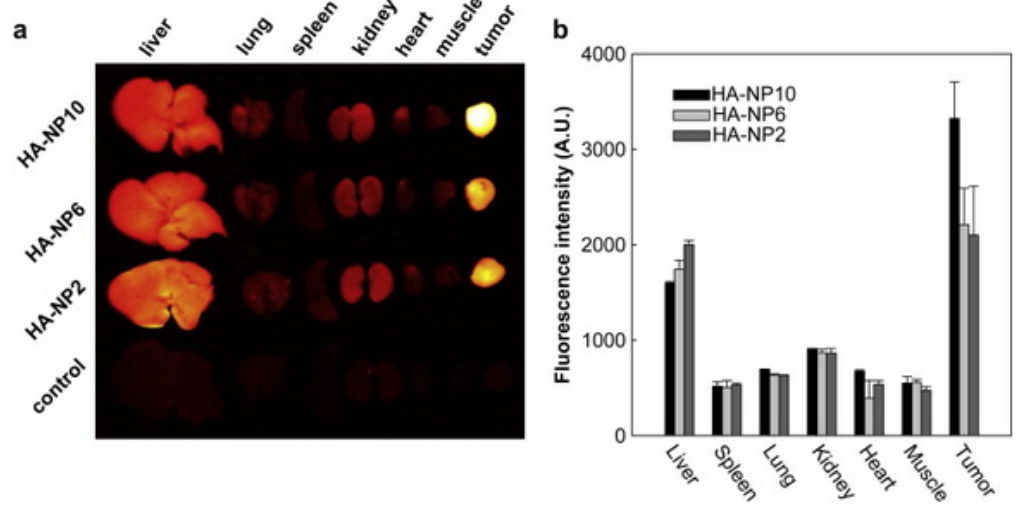
Figure 6. ( a ) Ex vivo fluorescence images of normal organs and tumors collected at two days post-injection of HA-NPs and; ( b ) Quantification of the ex vivo tumor targeting characteristics of hyaluronic acid nanoparticles (HA-NPs) in tumor-bearing mice. Error bars represent standard deviation ( n = 3) [75] (reproduced with permission from